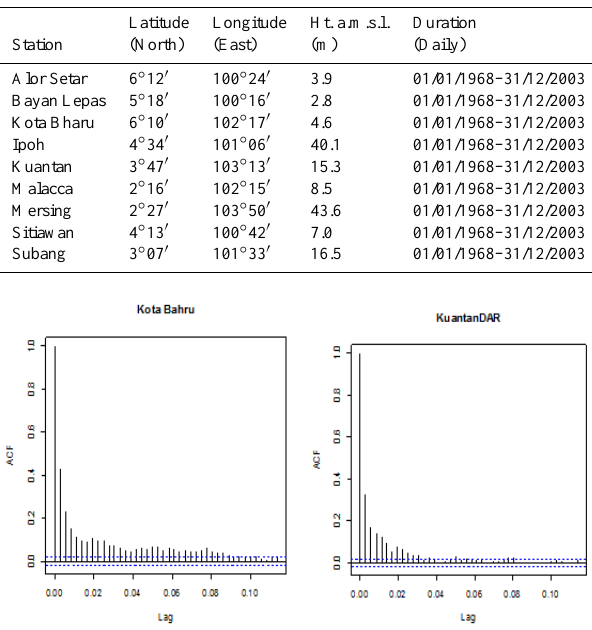
Table 1. Selected weather stations in Malaysia and their general geographic information.